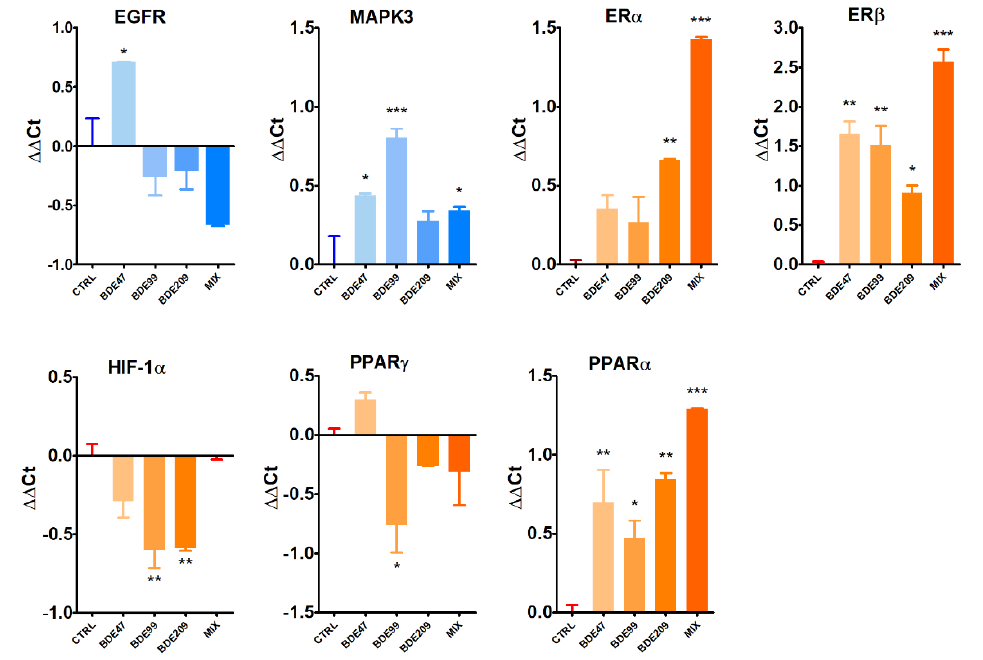
Figure 6. Gene expression analysis by qPCR of selected genes in HepG2 cells treated with BDE-47, BDE-99, BDE-209, or their ternary mixture (MIX) at 1 nM for 72 h. Asterisks indicate the level of significance: * p < 0.05, ** p < 0.01, *** p < 0.001.